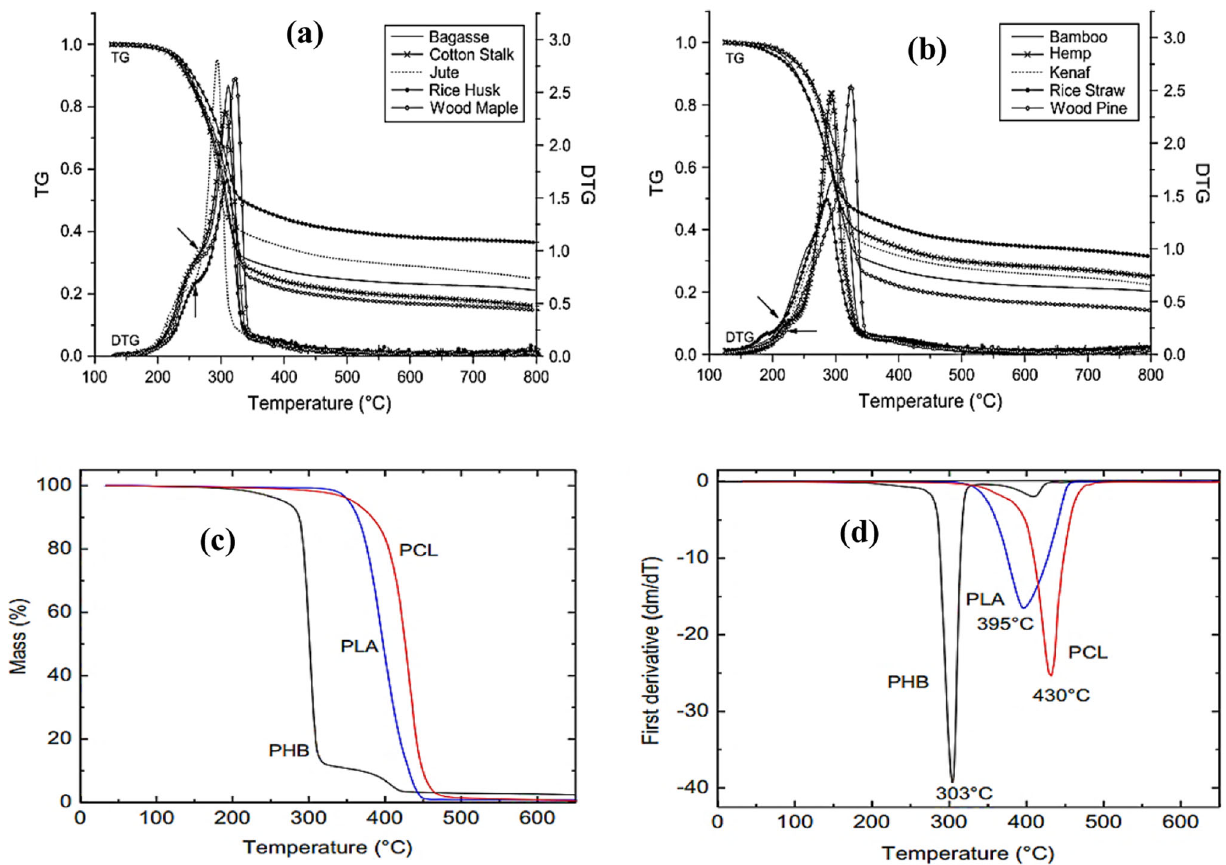
Fig. 11 Thermogravimetric decomposition of natural fi bers and biodegradable polymers. a Natural fi bers with obvious hemicellulose shoulders and b not obvious hemicellulose shoulders 135 c TGA for PCL, PLA, and PHB d DTGA for PCL, PLA, and PHB 136